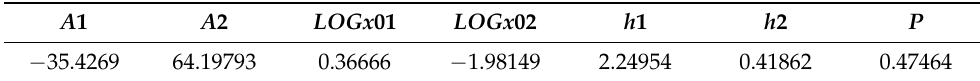
Figure 3. Image of the fitted Bidoseresp model in 2013. Table 1. BiDoseResp model coefficients.